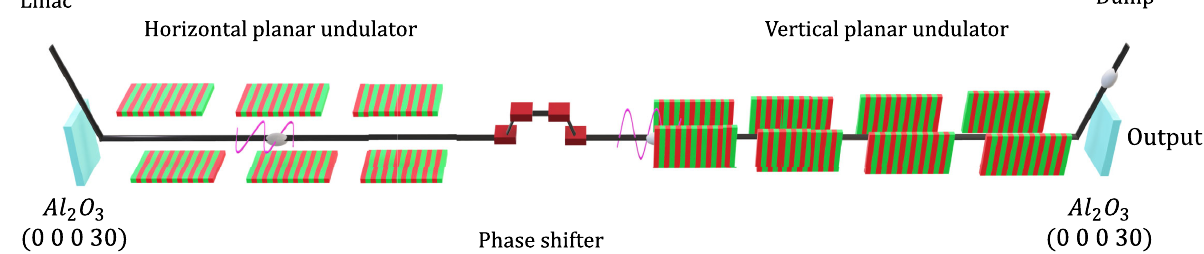
FIG. 1. A tapered crossed-polarized undulator is applied to an XFELO equipping with a pair of mirrors. The horizontally polarized radiation field is amplified in the first horizontal undulator, and the vertically polarized radiation field is amplified in the second tapered vertical undulator by a bunched electron beam. A phase shifter is placed between the undulators for controlling the polarization state. The output radiation is dumped from the downstream